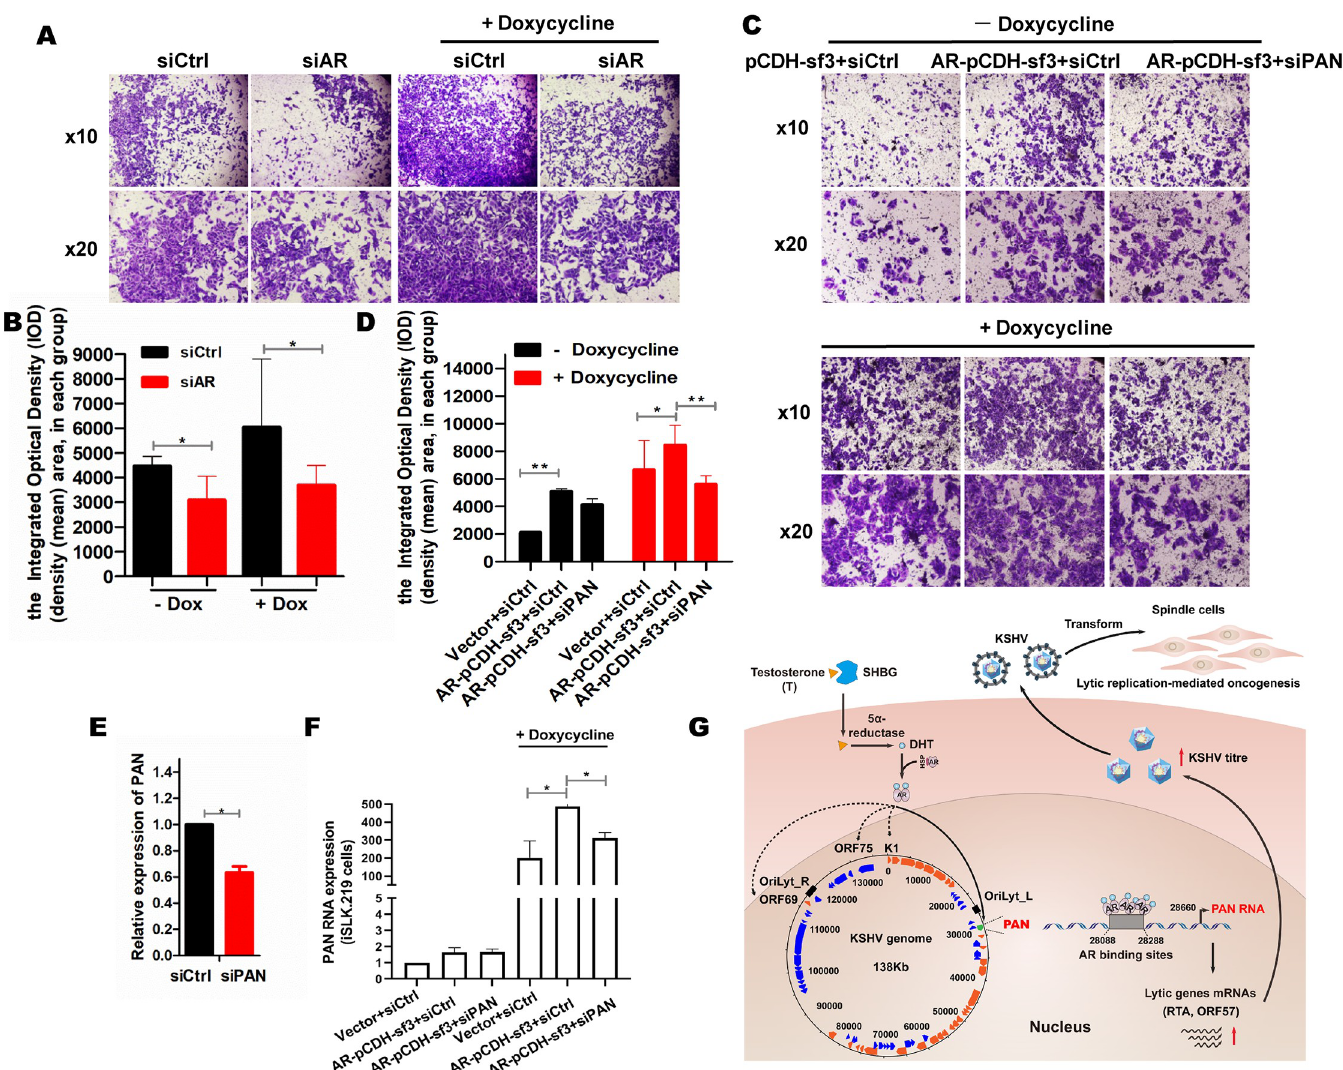
Fig 8. AR-mediated PAN facilitated cell invasion in the context of KSHV reactivation. (A) Knockdown of AR led to lower numbers of cells, notably after doxycycline treatment. iSLK cells were transfected with siAR or the scramble control for 48 h with or without doxycycline induction for 24 h. These cells were quantified and seeded into invasion chambers (Corning) for 24 h, and then the transwelled cells in each group were fixed and observed. Representative images were provided. (B) Number of cells in (A) was statistically analyzed. ImageJ software was used to quantify the absolute area of transwelled cells. The randomly selected three fields in each image were analyzed, and the total integrated optical density of individual images was calculated as (density (mean) × area). (C) Ectopic AR increased cell invasion, and the effect was impaired by additional siPAN expression. iSLK cells were transfected with AR-expressing lentivirus or vector virus for 24 h prior to co-transfection of siPAN or siCon for another 24 h with or without doxycycline induction for 24 h. The cells were treated as in (A) and observed. (D) Cells in (C) were quantified using ImageJ software. The procedure was identical as in (B). (E) efficiency of RNA interference to PAN was validated by approximately 40% reduction of PAN transcript in RT-qPCR assay compared with that in siControl, upon induction. (F) Inhibitory effect of siPAN on the ectopic AR was significant upon doxycycline induction. The mRNA level of PAN in the cells from (C) were detected and quantified by RT-qPCR as previously described. The cells transfected with control expressing plasmid and scramble siRNAs were used as the negative control. n.s., not significant; � P < 0.05; �� P < 0.01; ��� P < 0.001. Only the significant P value was indicated in the panel. Each reaction was repeated in, at least, triplicate. (G) Working model was